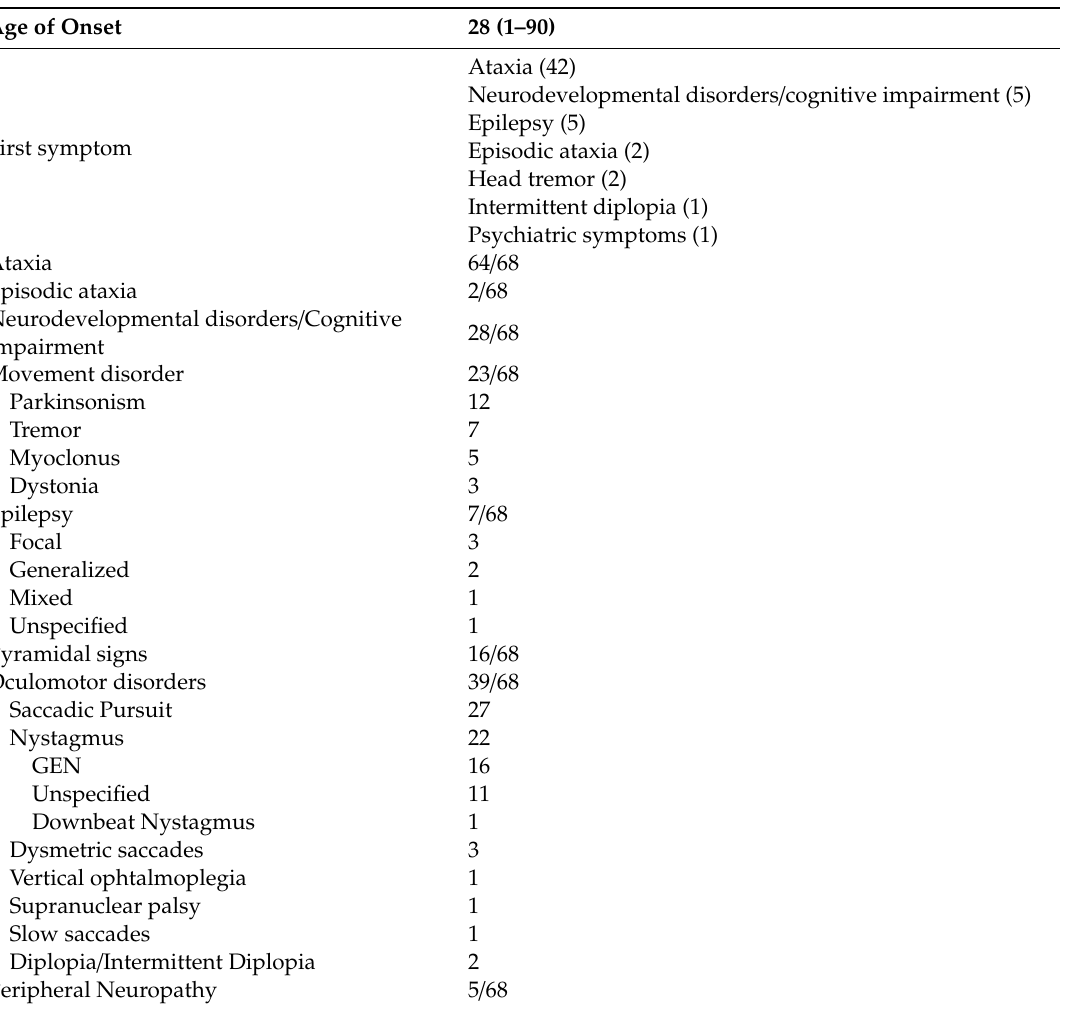
Table 1. Clinical data of 68 patients KCND3 mutation